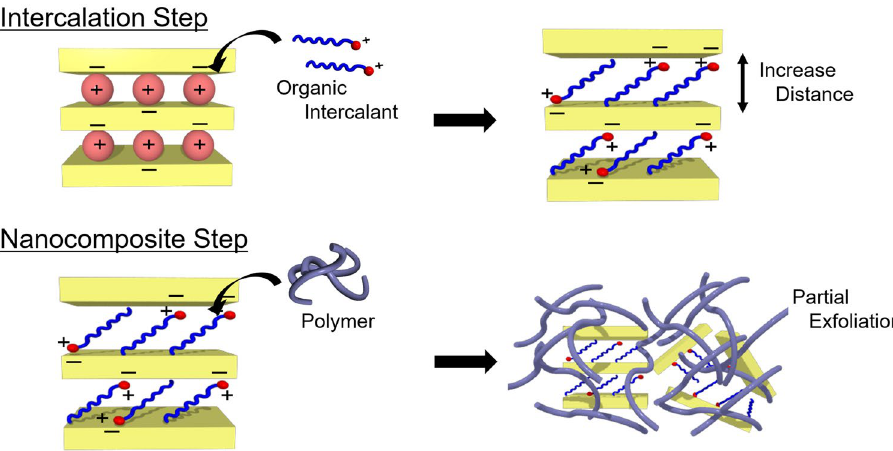
Figure 1. Schematic illustration of a polymer–clay nanocomposite formed using the intercalation method. In the intercalation step, organic intercalants penetrate the interlayer space. The internal cations are exchanged for the organic intercalants because they have higher affinities for the silicate layers than for the cations. The interlayer distance is increased after intercalation. Subsequently, polymer molecules penetrate the interlayer space of the modified clay, which has partially separated in the polymer